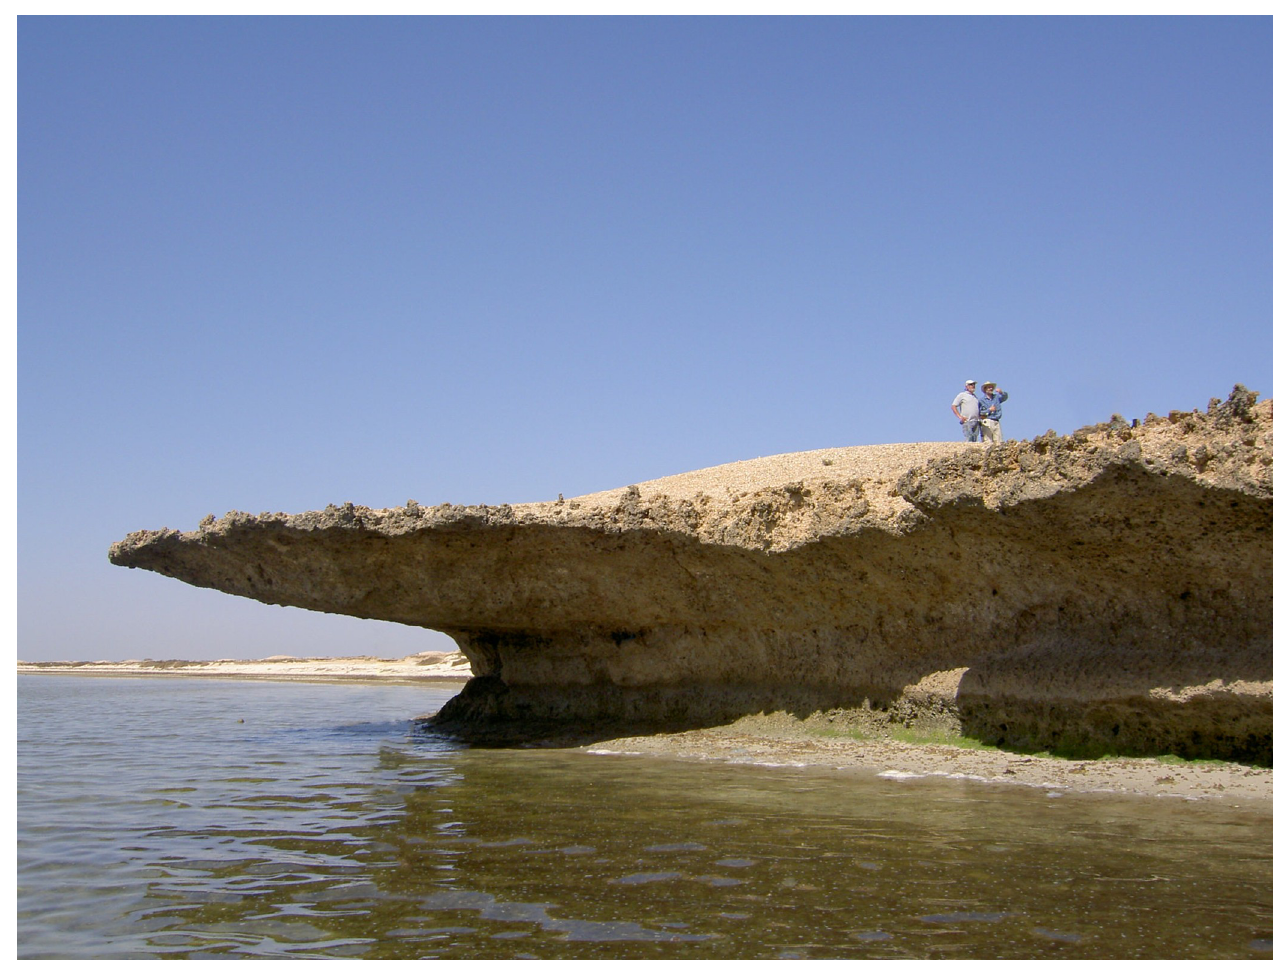
Fig 2. The edge of the coral platform in Janaba East, showing a notch deeply undercut by marine erosion. Above it is a shell mound located with two figures standing on it. This undercut terrace is of variable extent along the Janaba Bay shoreline and is not present on the shoreline in the background nor associated with the sites in Transects 2 and 3, where the shallow gradient onshore and offshore has resulted in an almost imperceptible break between the landward surface of the fossilised coral platform and the offshore surface, Photo by Garry Momber, May